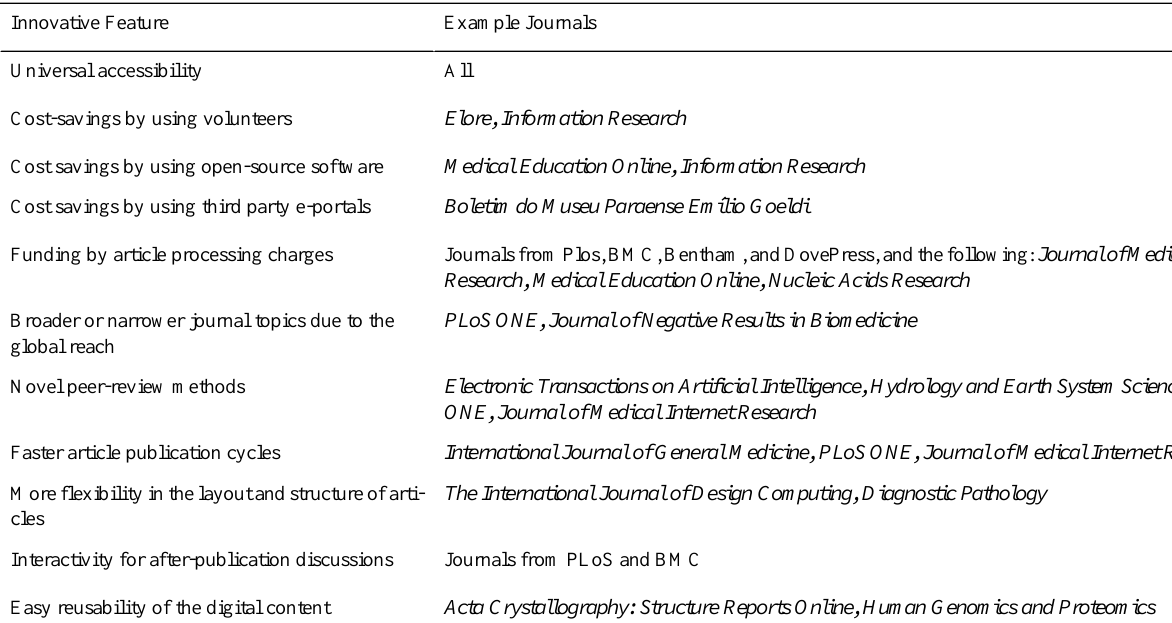
Table 3. Innovative features discussed in the article and journals that provide good examples of each feature.